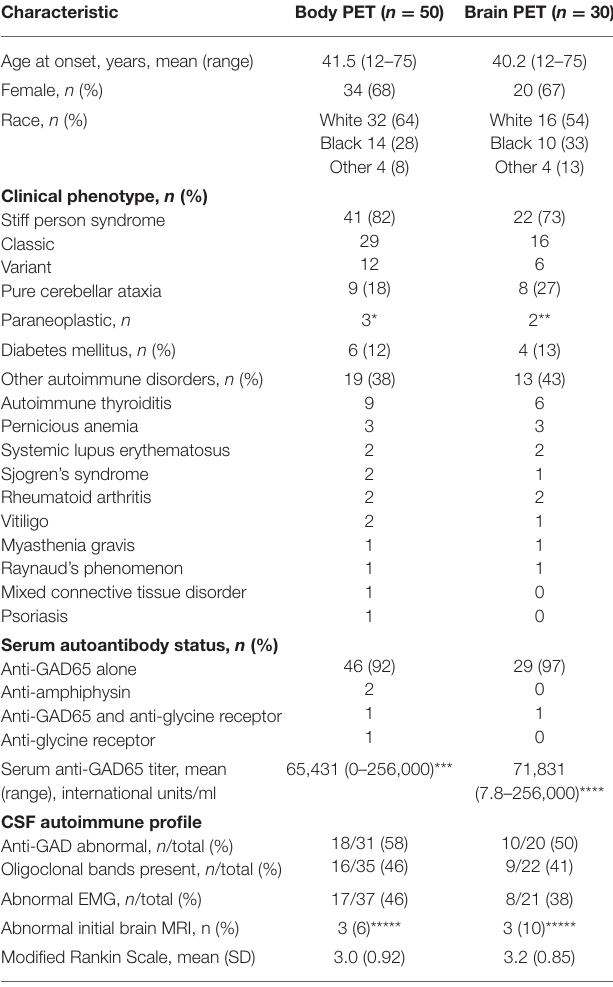
TABLE 1 | Participant demographics, clinical characteristics, and immunological profile.